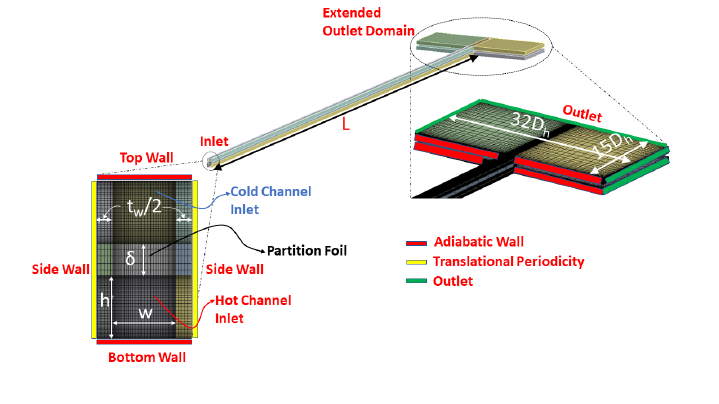
Figure 2. Mesh and geometric details for co-current conjugate heat transfer (CHT)